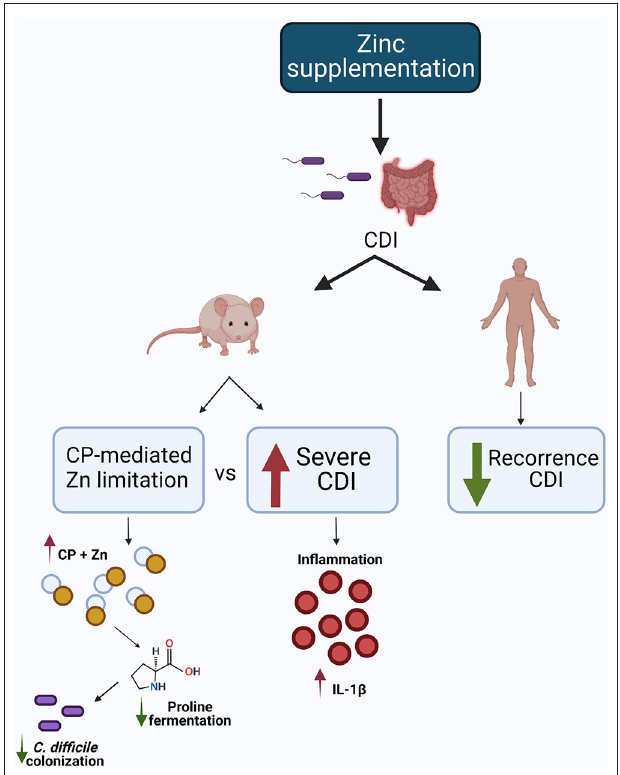
FIGURE 3 | Possible mechanism of zinc in CDI. In the animal model, one study showed that dietary Zn supplementation increased CDI severity, while another demonstrated calprotectin-mediated zinc limitation, reducing proline fermentation and, consequently, C. difficile colonization. In the human study, Zn supplementation reduced CDI recurrence. Created with